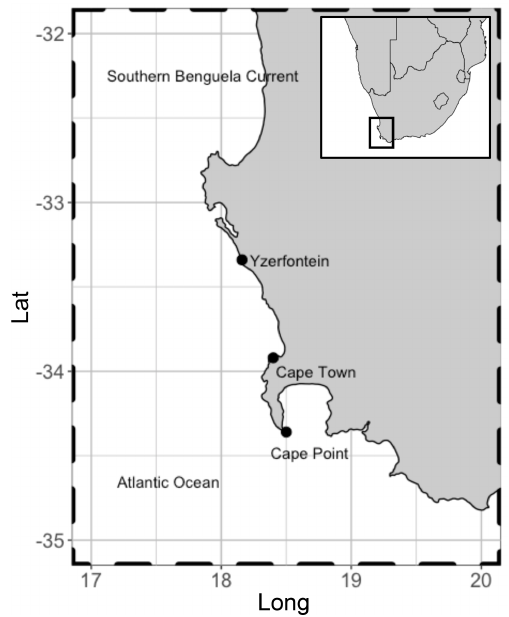
Figure 1. Location of Cape Point in relation to Cape Town. Kelp range along the entire coast. These are dominated by Ecklonia max- ima Papenfuss south of Yzerfontein but transition to predominantly Laminaria pallida north of Yzerfontein. Adapted from Kuyper